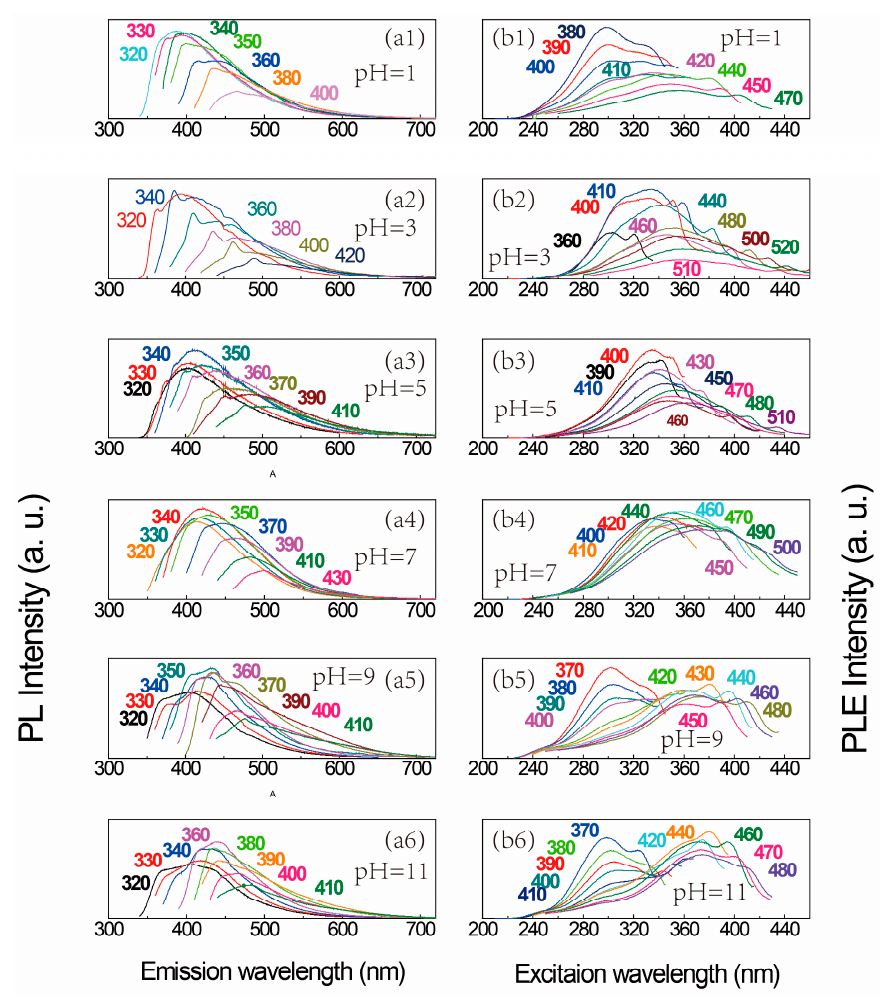
Figure 4. PL spectra from silicon NCs colloid with pH values of ( a1 ) 1, ( a2 ) 3, ( a3 ) 5, ( a4 ) 7, ( a5 ) 9, and ( a6 ) 11. PLE spectra from silicon NCs colloid with pH values of ( b1 ) 1, ( b2 ) 3, ( b3 ) 5, ( b4 ) 7, ( b5 ) 9, and